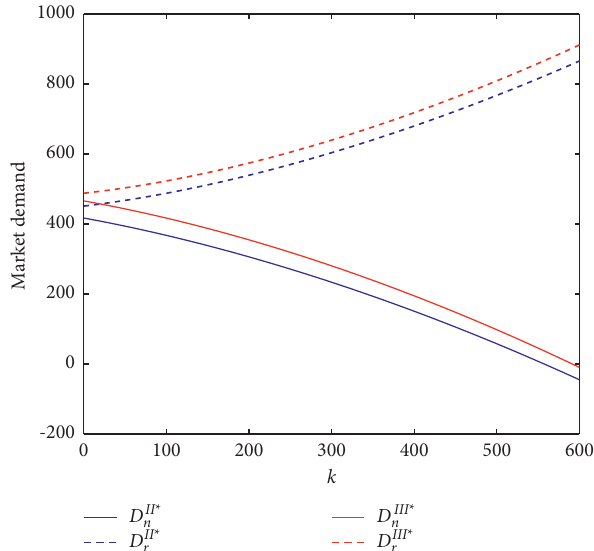
Figure 6: The effects of k on market demands.